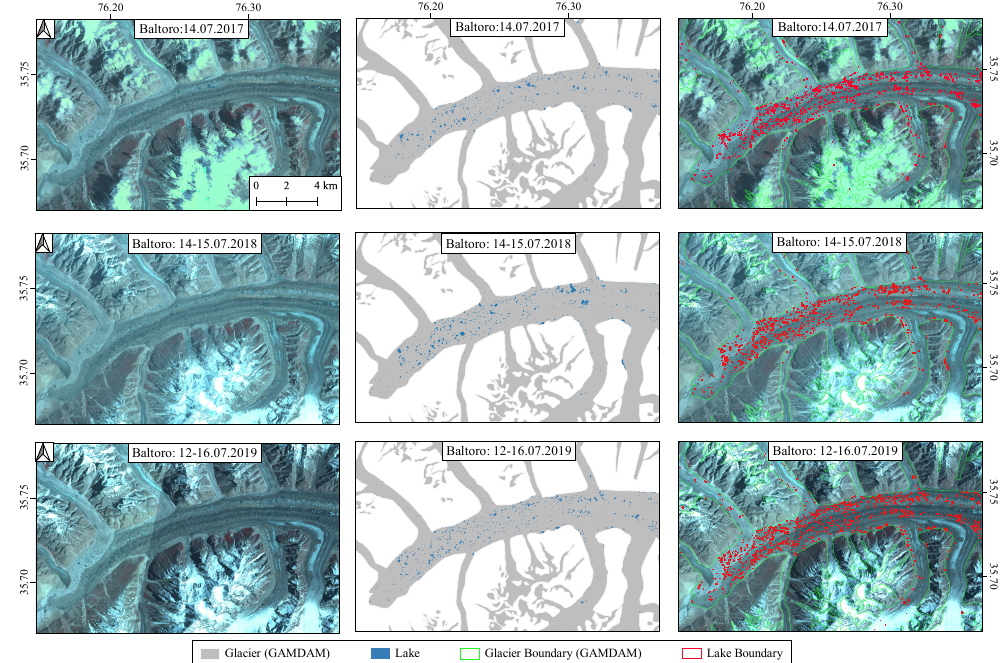
Figure 10. Annual variations in the supraglacial lakes on the Baltoro glacier. These images were acquired with approx. one year time difference. Mapped glacial lakes using the U-Net model are shown in the middle. Lake boundaries are displayed on the FCC PlanetScope